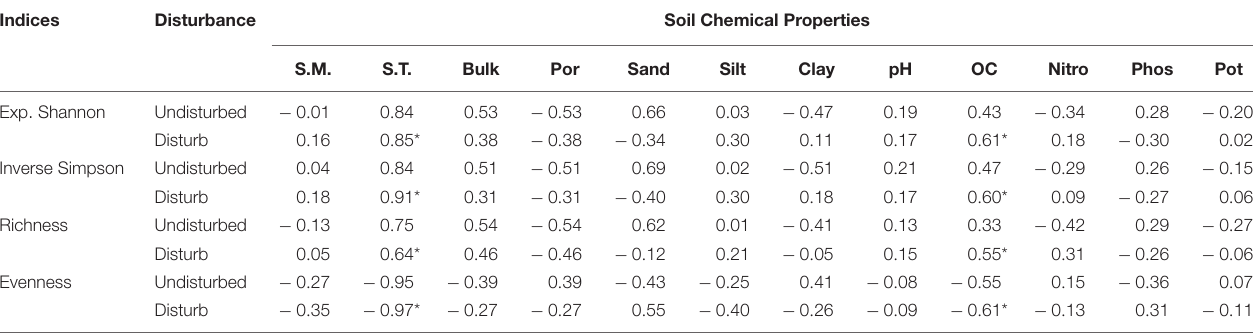
TABLE 3 | Correlation coefficients between phytosociological indices and soil parameters in GHNP. Indices Disturbance Soil Chemical Properties S.M. S.T. Bulk Por Sand Pot Exp. Shannon Inverse Simpson Undisturbed Richness Undisturbed Evenness Undisturbed − 0 .